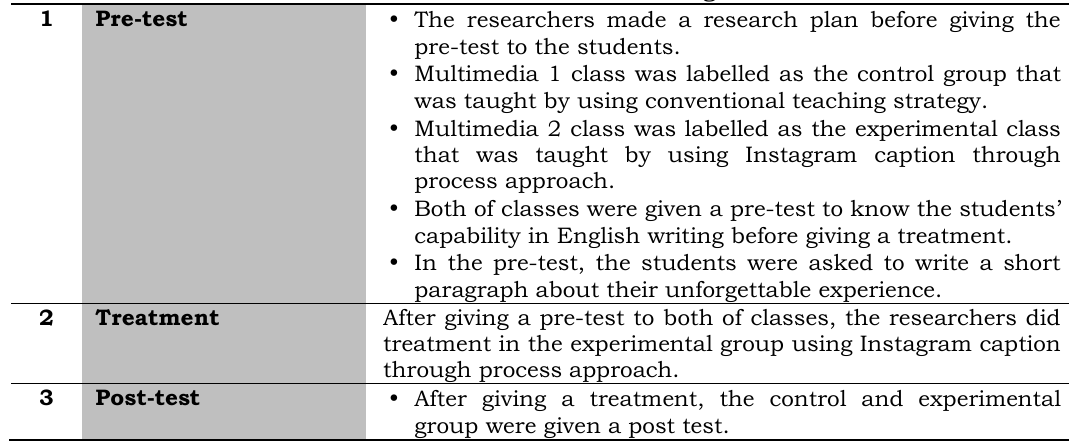
Table 1. Procedure of Collecting